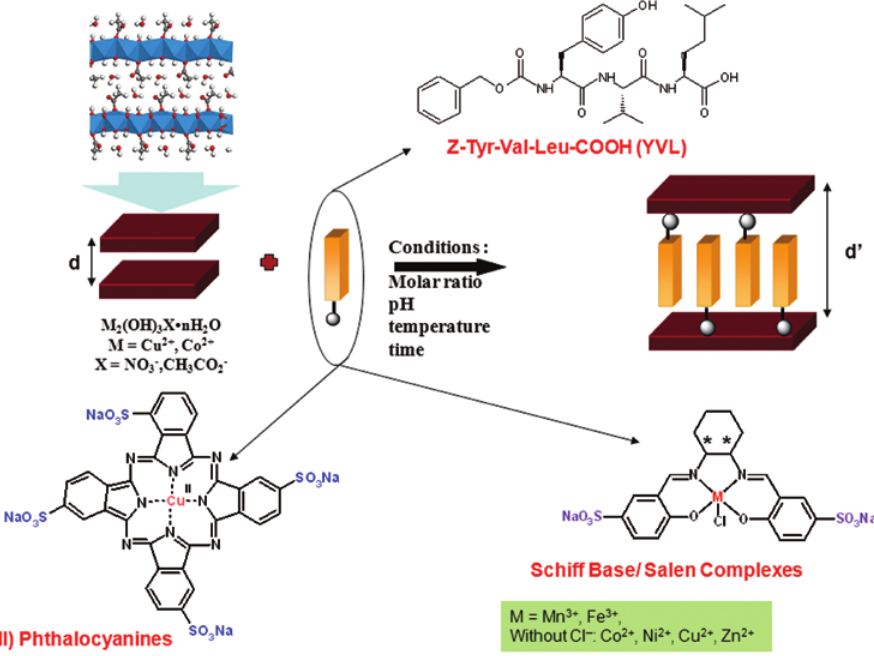
Scheme 2: Synopsis of exchange reactions performed in lamellar hydroxides from functional molecules, as metal complexes or bio- inspired molecules with optical